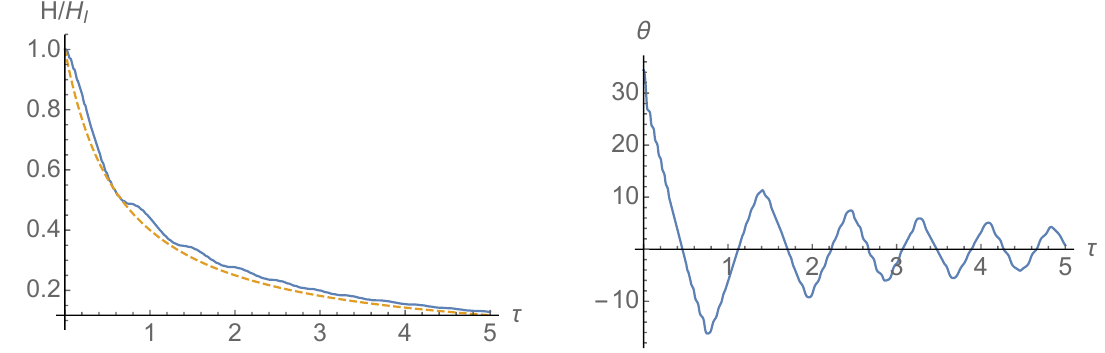
Figure 3 . The evolution of the Hubble parameter (left panel) and the in(cid:13)aton value (right panel) with respect to (cid:28) = H I t in the case with h 0 = (cid:3) = 0 : 08. The dashed line in the left panel is the Hubble evolution of the standard matter